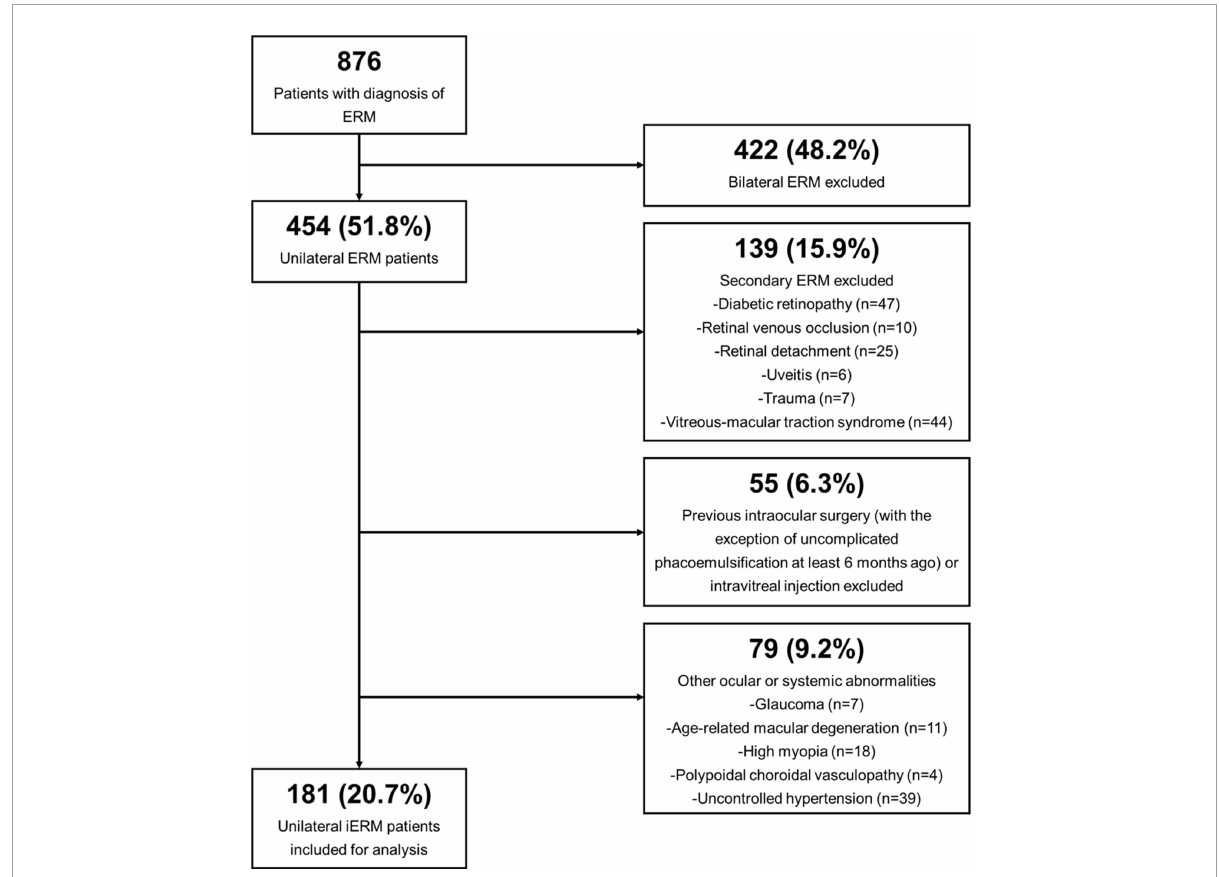
FIGURE1 Flow diagram demonstrating the selection process of enrolled unilateral idiopathic epiretinal membrane (iERM) subjects.